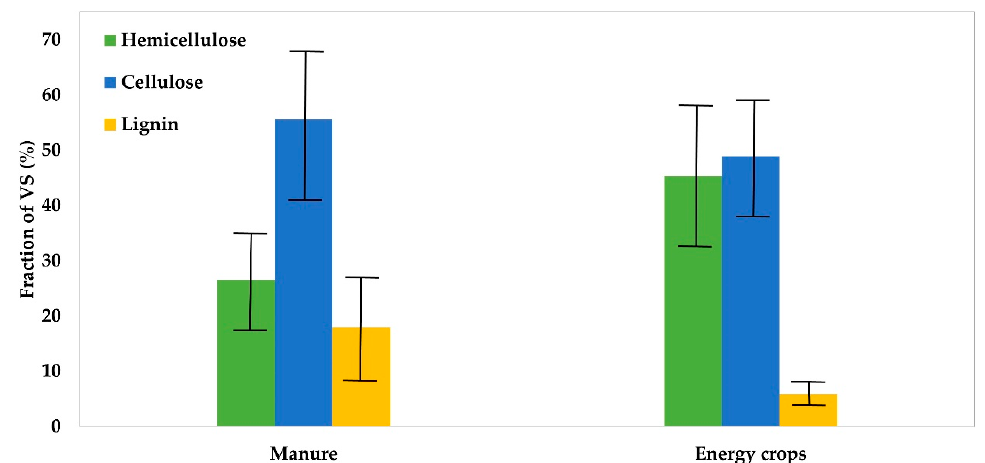
Figure 2. Composition of hemicellulose, cellulose and lignin contents as a percentage of volatile solids (VS) in manure and energy crops (data from Triolo et al . [11]).